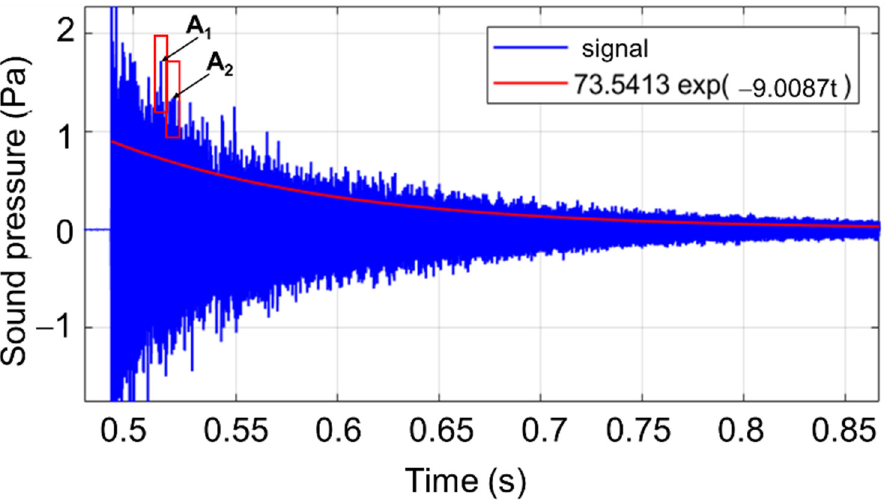
Figure 4. The experimental time response analysis.